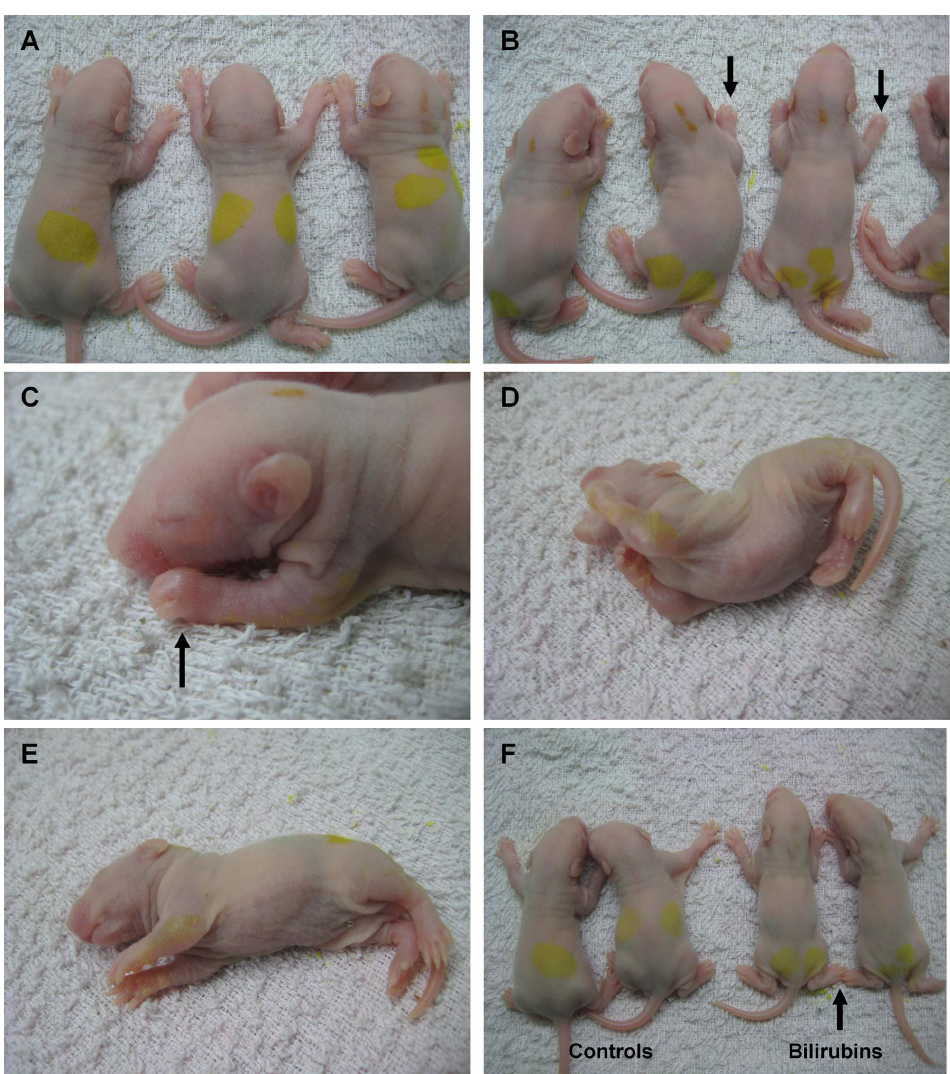
Figure 1. Clinical manifestations within 0.5–1 hour after bilirubin injection. (A) Control group rats. No abnormal neurobehavior was detected in the controls. (B)–(E) Representative images of abnormal neurobehavior in bilirubin-treated rats. Almost all of the bilirubin-treated pups showed clenched fists (B–C) (black arrow) and opisthotonos (D); some rats showed the latericumbent position (E). (F) Comparison of prostration in the two groups. The bilirubin-treated rats show decreased muscular tone (black arrow) and